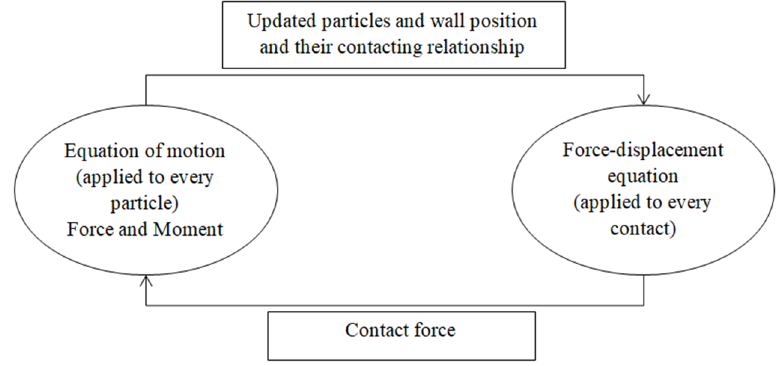
Figure 10. Calculation cycle process of Particle flow code (PFC).